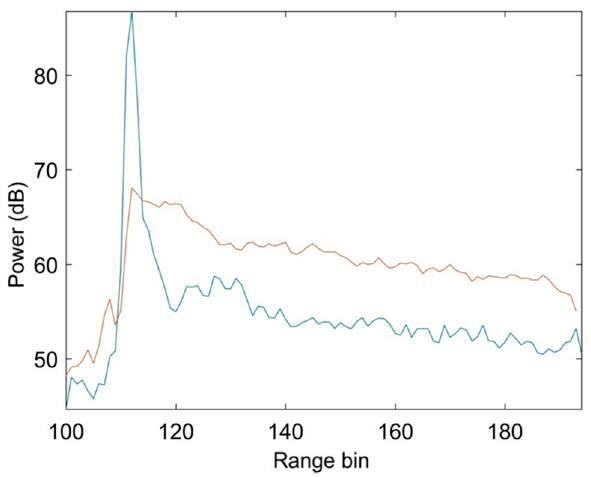
Figure 16. Specular waveform of Semliki echoes (blue), compared with the Brownian Edward Lake (red).